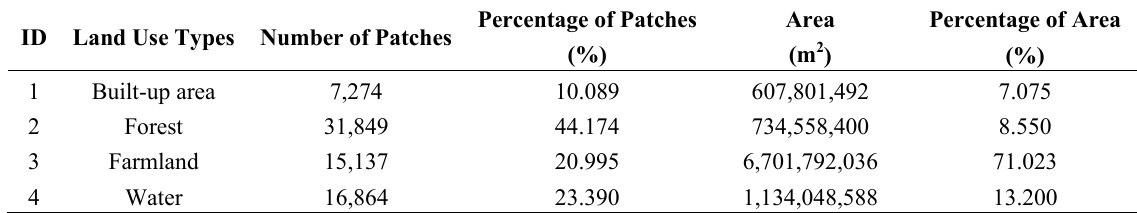
Table 1. The classification results of satellite-detected land use information in